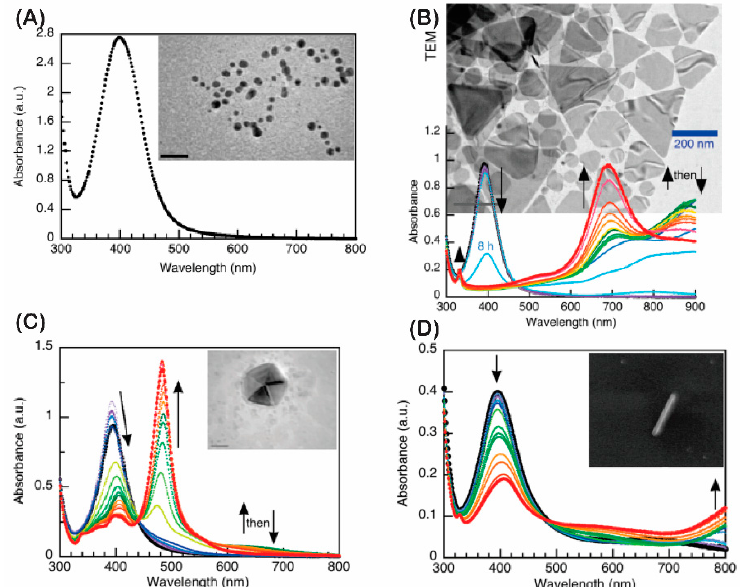
Figure 3. The change absorbance conversion during irradiation (initial in black, final in red) of UV − vis spectrum with irradiation time and TEM image shows the morphology of the particles formed. ( A ) The AgNP seeds after UVA irradiation, ( B ) 627 nm LED excitation of AgNP seeds, ( C ) 455 nm LED excitation of AgNP seeds, and ( D ) 720 nm LED irradiation. Adapted with permission from [57], Copyright 2010, American Chemical Society.